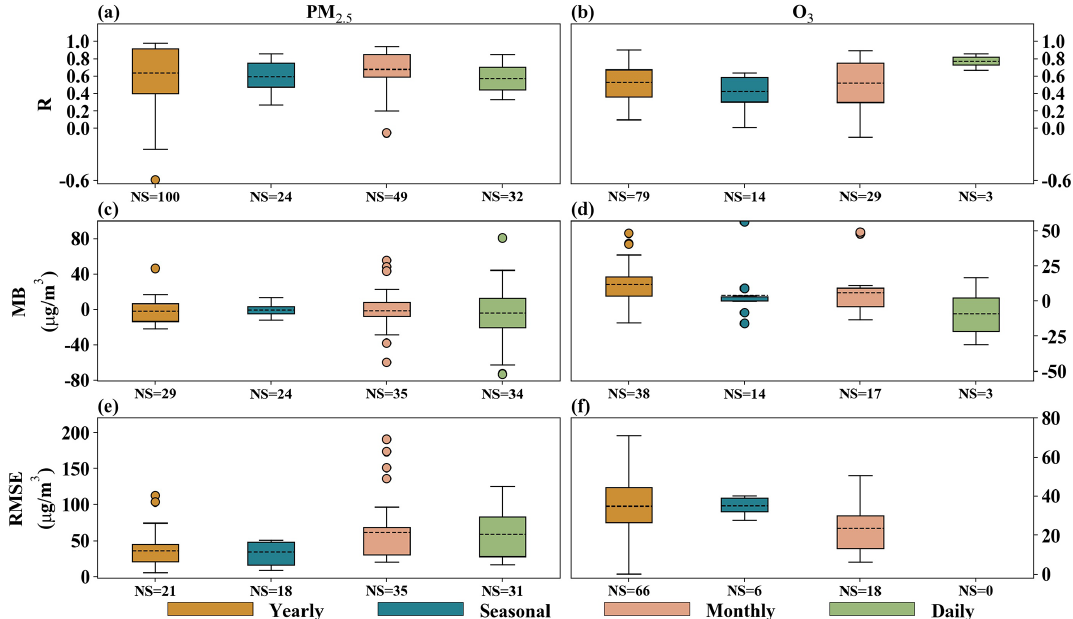
Figure C2. The quantile distributions of simulated PM 2 . 5 and O 3 performance metrics at different temporal scales from past studies in Asia.